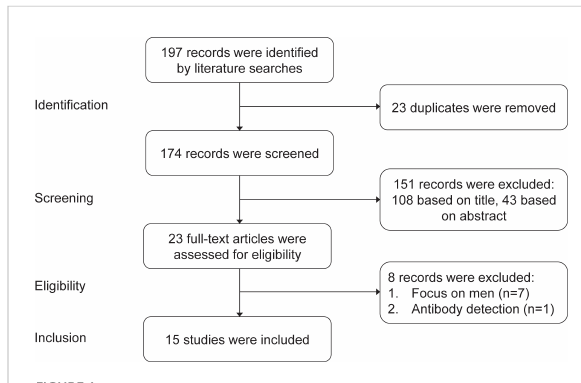
FIGURE 1 Flow chart of screening studys into systematic